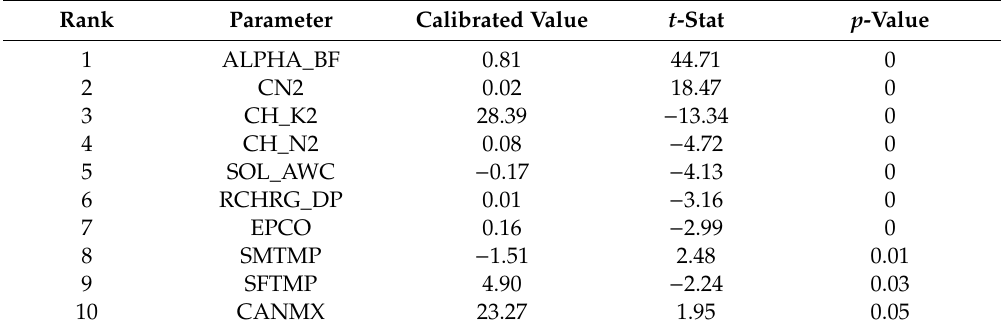
Table 7. List of top 10 ranking sensitive parameters for SWAT in the LEC watershed and their calibrated